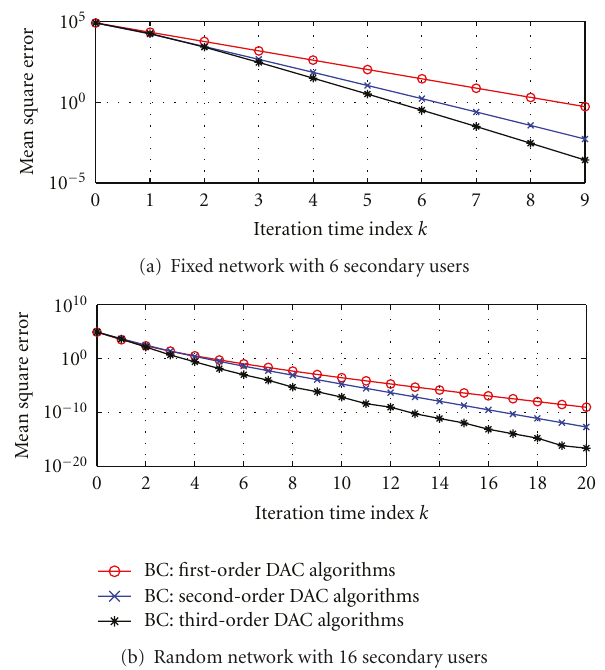
Figure 4: Convergence rate comparison of first-, second-, and third-order DAC algorithms: (a) fixed network with 6 nodes (Case 1) and (b) random network with 16 nodes (Case